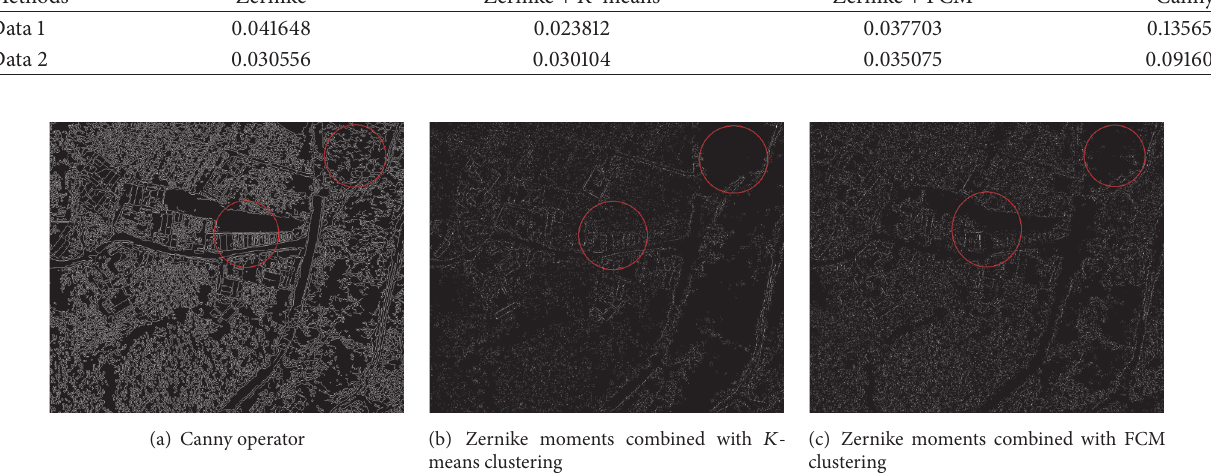
Figure 6: The results of second experiment for Data 1.